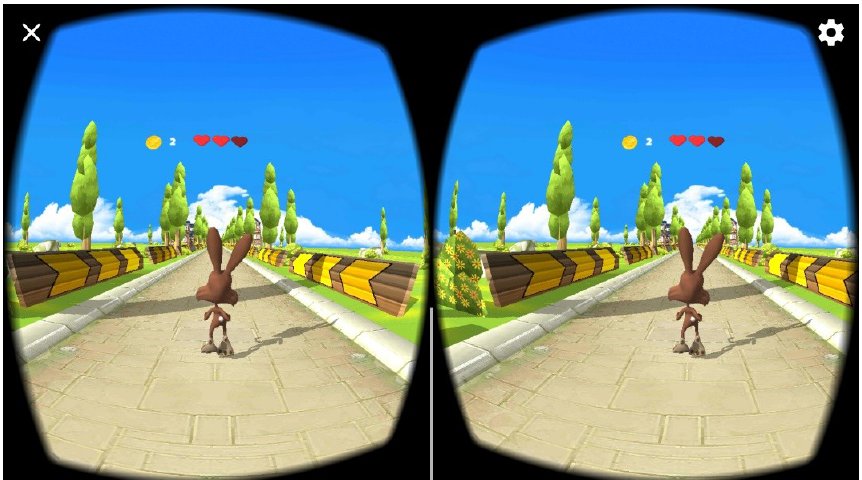
F igure 3. Gameplay of RabbitRun game. Figure 3. Gameplay of RabbitRun game.